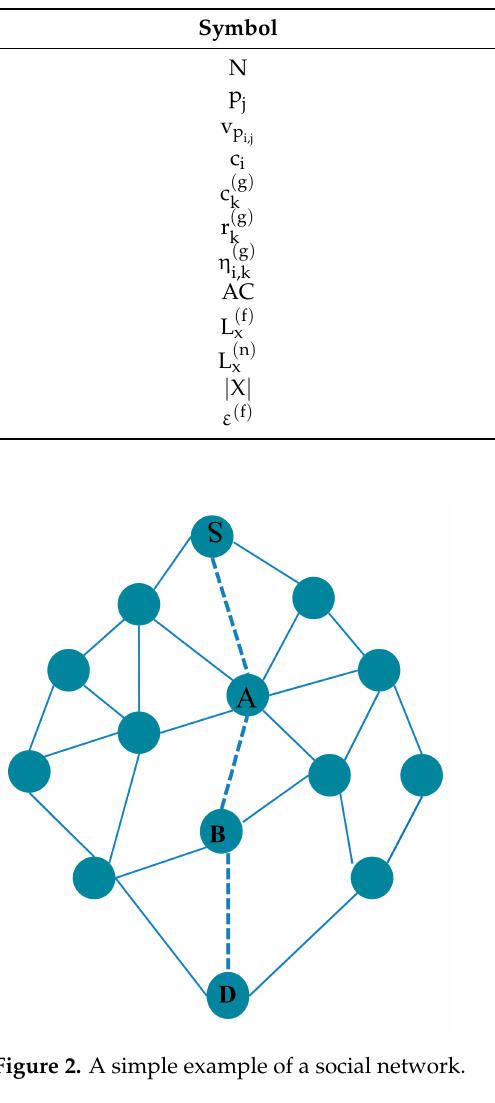
Table 2. Notations used in the rest of this paper.